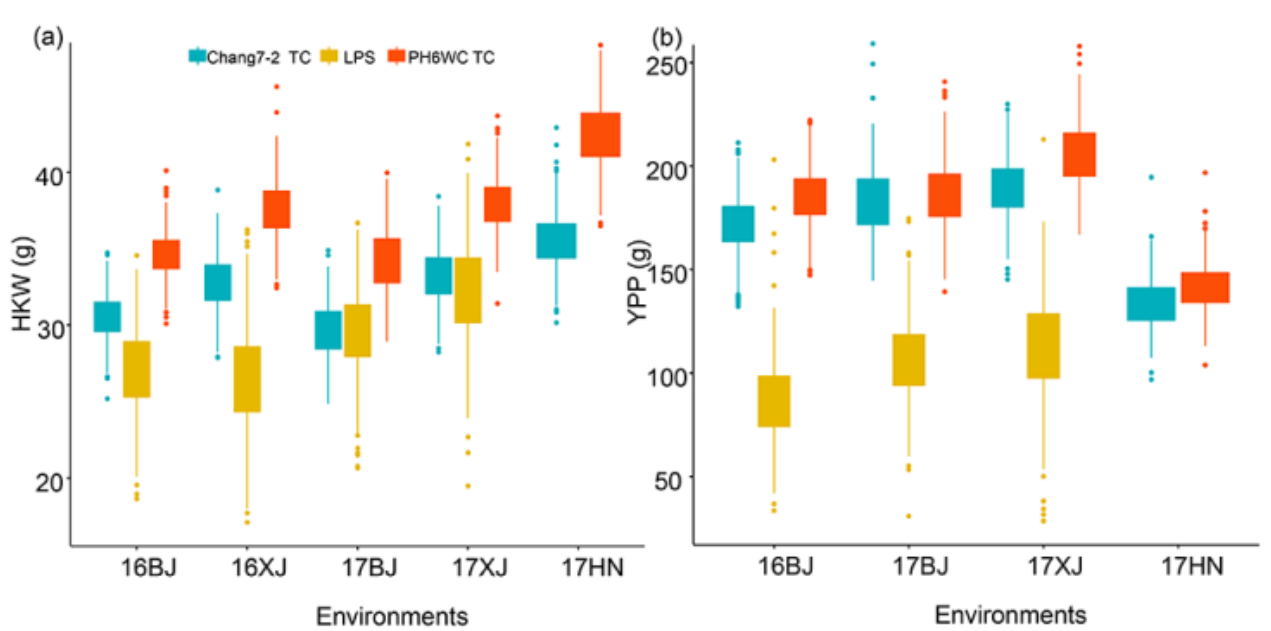
Figure 1. Boxplot showing the distribution of HKW and YPP of the three populations. ( a ) and ( b ) Distribution of HKW and YPP, respectively. Table 1. Basic statistical analysis of HKW and YPP of the three populations.